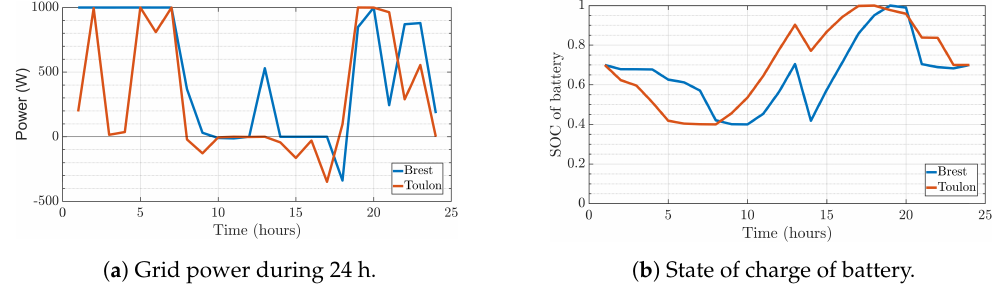
( a ) Grid power during 24 h. ( b ) State of charge of battery. Figure 11. Case study 2: Grid power and batteries state of charge for Brest and Toulon.